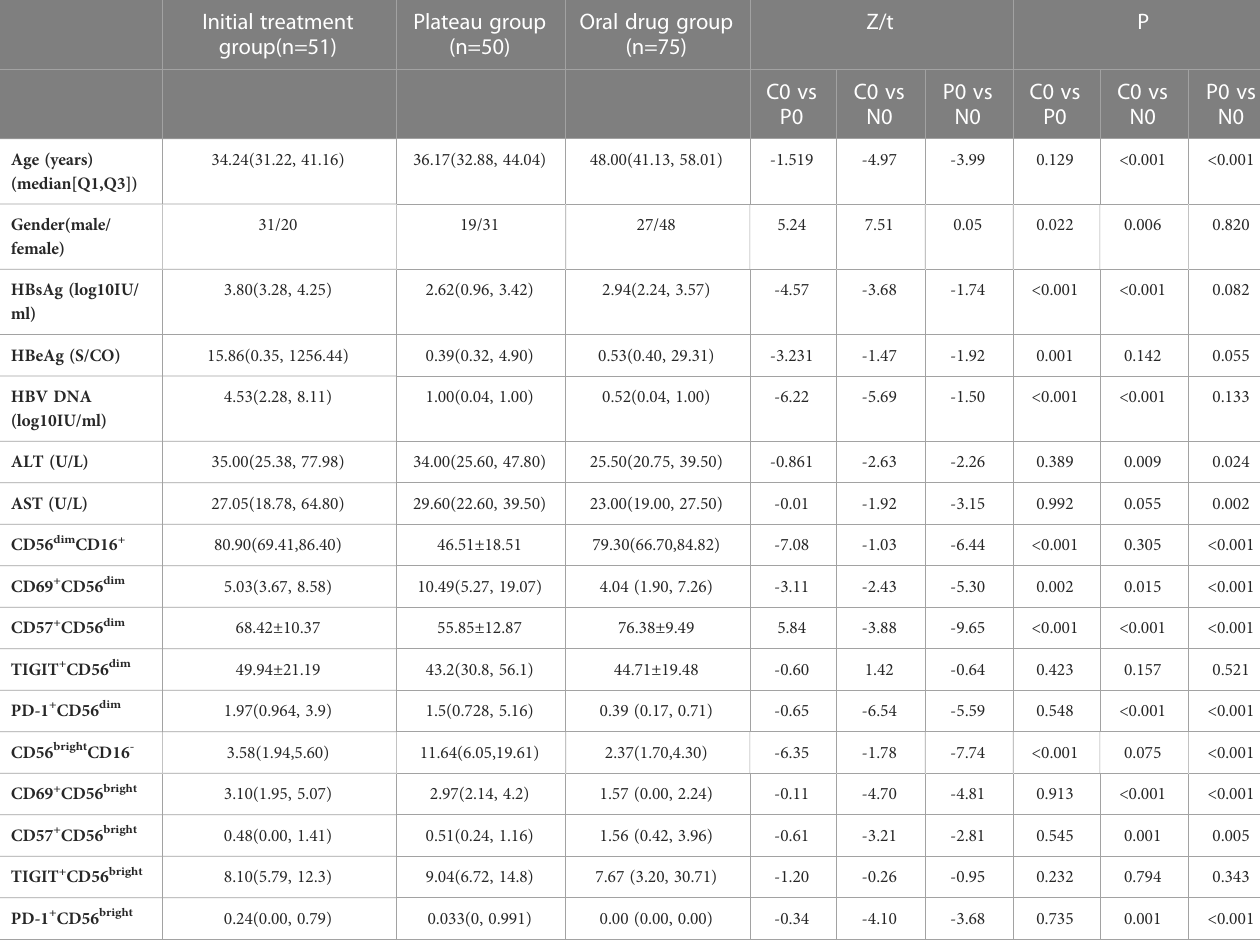
TABLE 1 Characteristics of initial treatment group, plateau group and oral drug group at baseline. Initial treatment